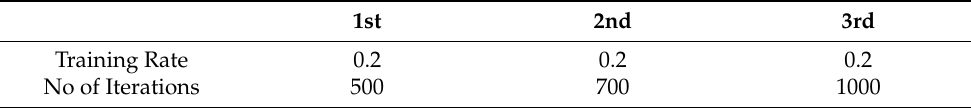
Table 2. Training rate and iterations for CNN